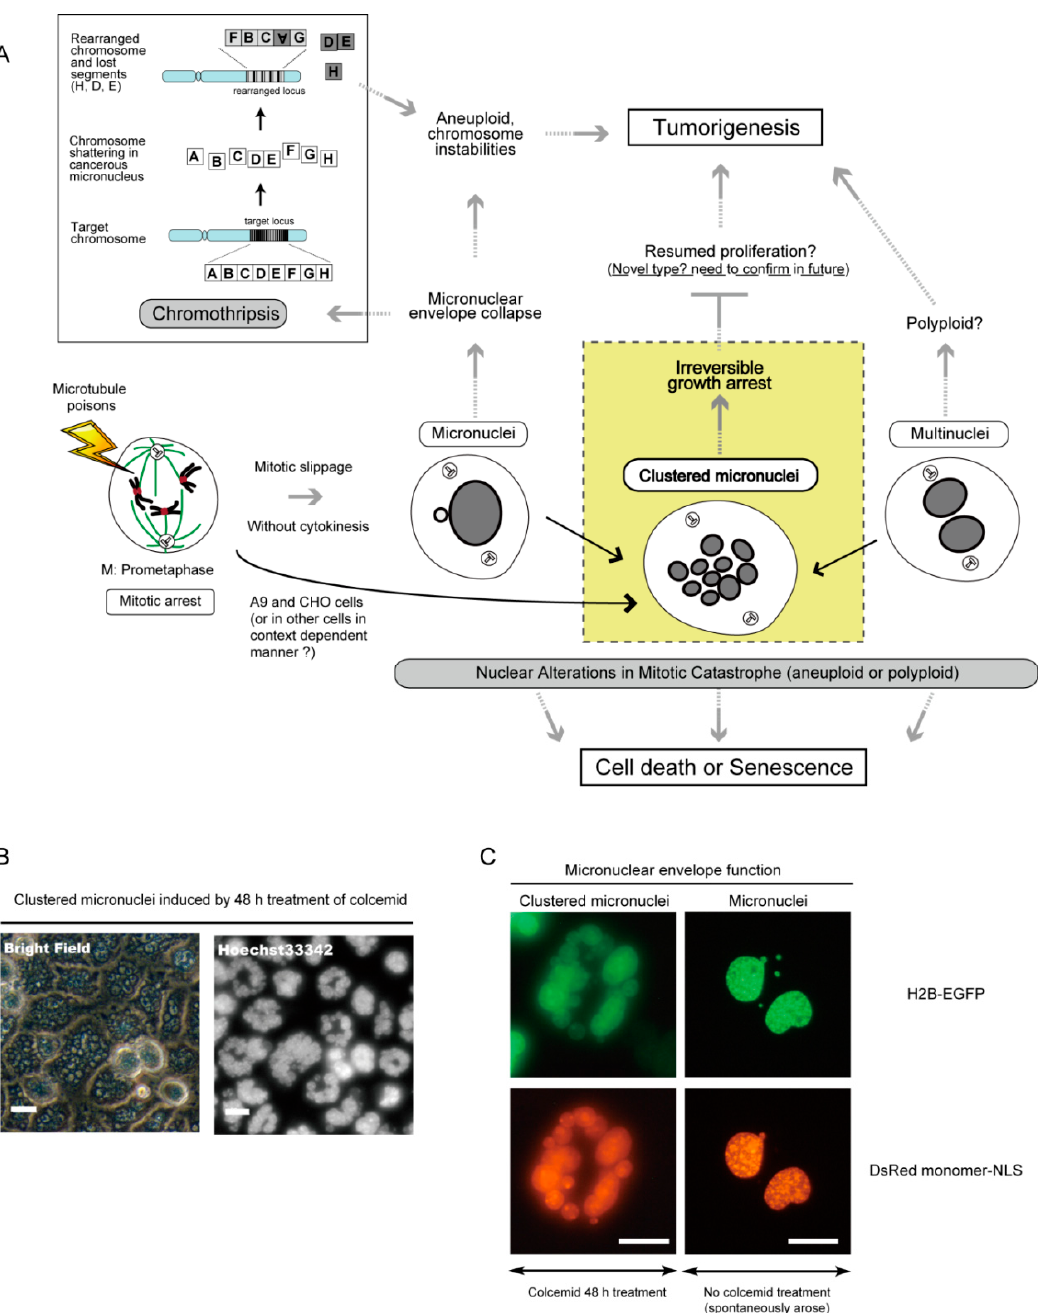
Figure 4. Two conventional nuclear alterations, and a new type, in mitotic catastrophe. ( A ) Conventional micronuclei can be a source for chromothripsis, which may lead to chromosome instabilities and tumorigenesis. In contrast, clustered micronuclei are thought to have a low chance to cause such genomic instabilities, since they could reach irreversible growth arrest and possess functional micronuclear envelopes as shown in Figure 4C. Cells with multinuclei may also contribute to tumorigenesis. Black arrows indicate a challenging, but not established, beneficial effect converting any of the nuclear alterations into clustered micronuclei. For details, see the text; ( B ) Morphological features of clustered micronuclei in mouse A9 cells are shown. DsRed monomer-NLS allows the production of monomeric DsRed protein fused to a nuclear localization signal. After 48 h of treatment with colcemid, clustered micronuclei are visible via light microscopic observation. Scale bars; 20 μ m; ( C ) Each micronucleus within clustered micronuclei possesses a functional micronuclear envelope, but not micronuclei. Note that the micronuclei showed in the right panels arose spontaneously and are observed in a giant cell that has two large nuclei with three independent very small nuclei without functional nuclear envelope. Scale bars; 20 μ m.